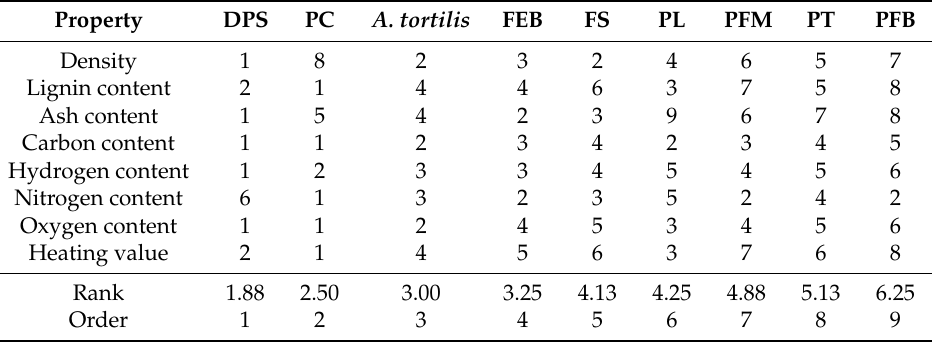
Table 6. Rating of the eight date palm residues regarding some measured